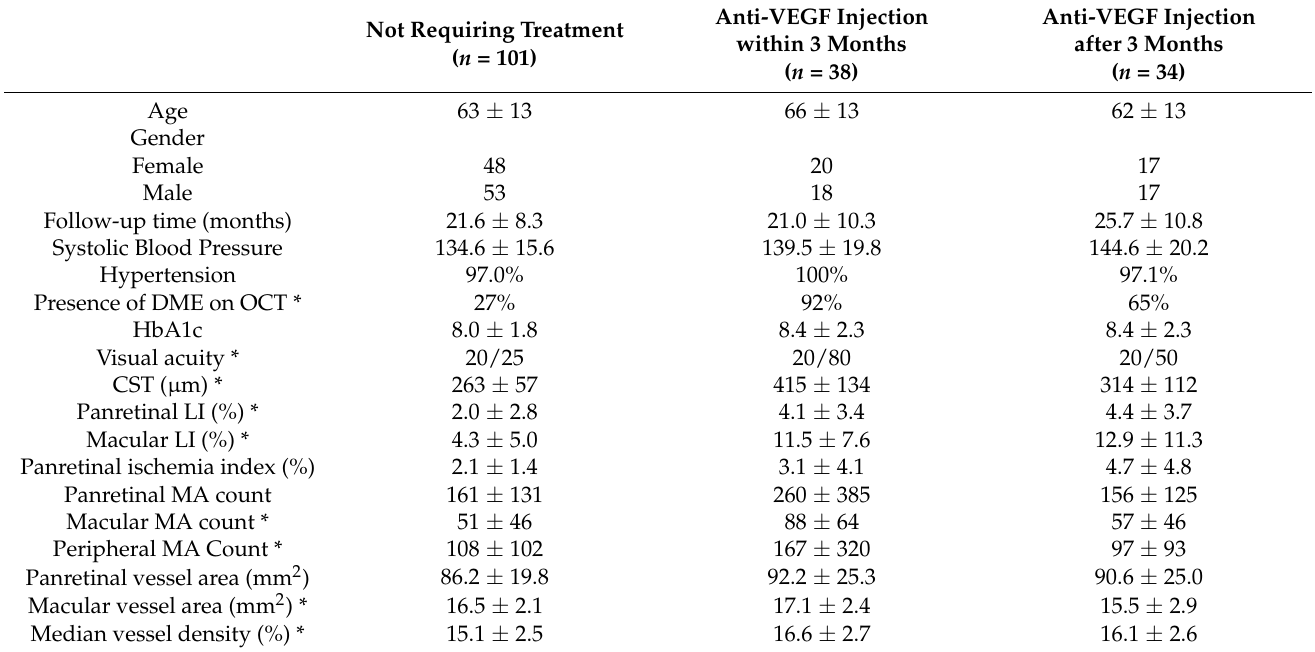
Table 1. Summary of select characteristics and imaging features for each treatment group.